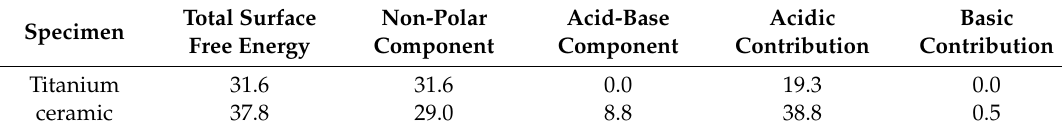
Figure 2. Average contact angles ( ± SD) of the three probe liquids on the material tested. Table 1. Surface free energy (mJ / m 2 ) of the tested specimens determined by the Good–van Oss theory (vOGT).